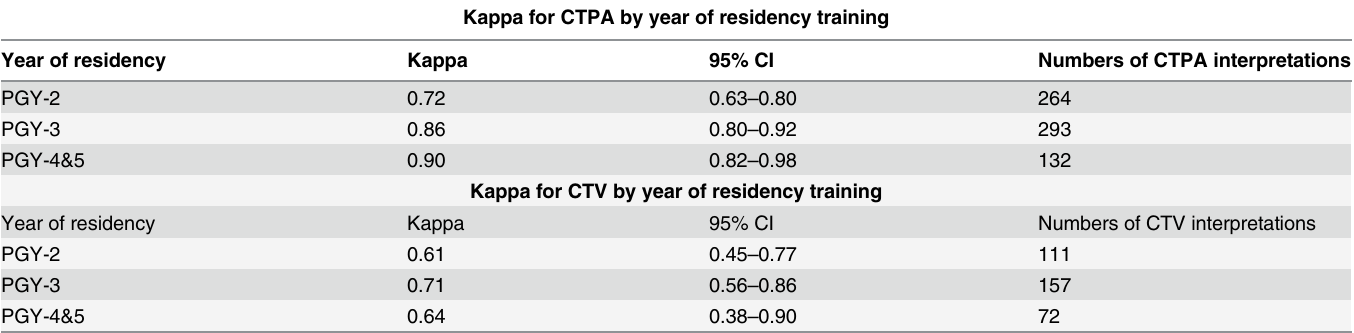
Table 4. Agreement between resident and staff radiologists according to the year of residency for PE and DVT diagnosis for the 3 outcomes (Posi- tive, Negative, Indeterminate). Kappa for CTPA by year of residency